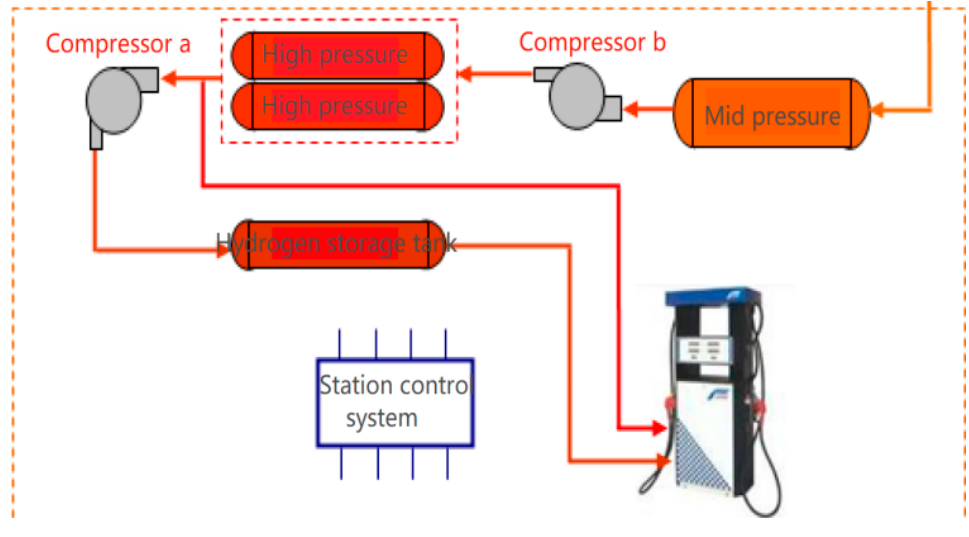
Figure 1. Hydrogenation process.